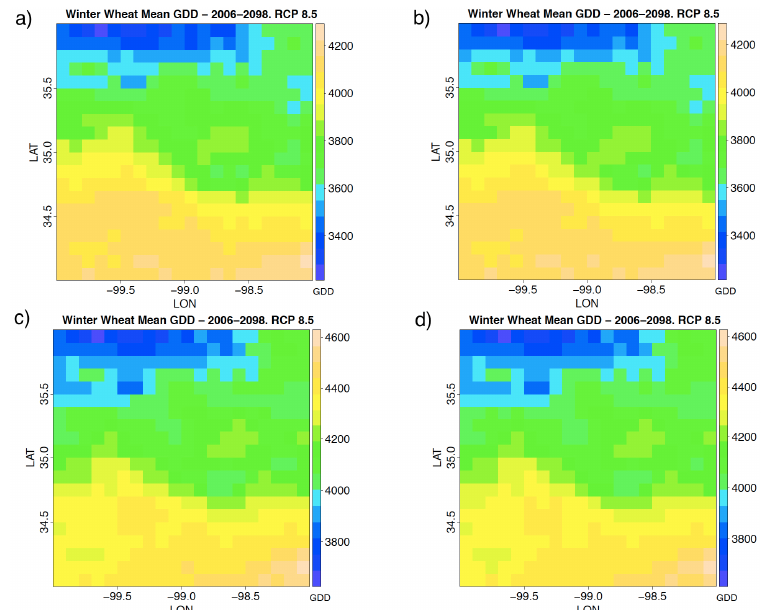
Figure 7. Mean GDD derived from the RCP 8.5 future projections (2006–2098) and four GCM/downscaling model combinations: ( a ) Top left—outputs for the CCSM4 GCM and CDFt downscaling method. ( b ) Bottom left—outputs for the CCSM4 GCM and EDQM downscaling method. ( c ) Top right—outputs for the MIROC5 GCM and CDFt downscaling method. ( d ) Bottom right shows the outputs for the MIROC5 GCM and EDQM downscaling method.